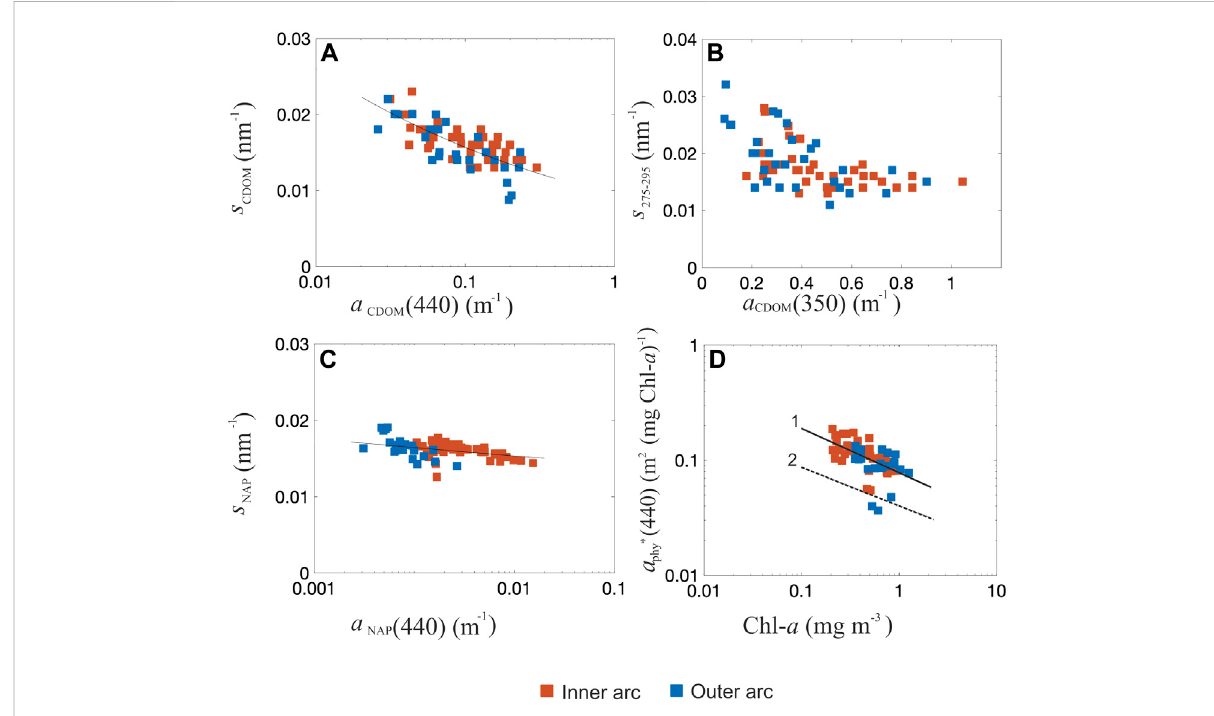
FIGURE 5 Slopes of bio-optical properties and a phy *. Regressions of (A) S CDOM(350 – 750) versus a CDOM(440) . (B) S CDOM(275 – 295) versus a CDOM(350) . (C) a n = 70). The plots A and C displayed in semi-log scale, with y axes are in slope units (nm − 1 ). (D) Relationship between S NAP(350 – 750) versus NAP(440) ( phytoplankton-speci fi c absorption coef fi cient at 440 nm as a function of Chl- a ( n = 68) (log scale). The solid (line 1) and dashed (line 2) lines are the regression models obtained in this study and from Bricaud et al. (1995)